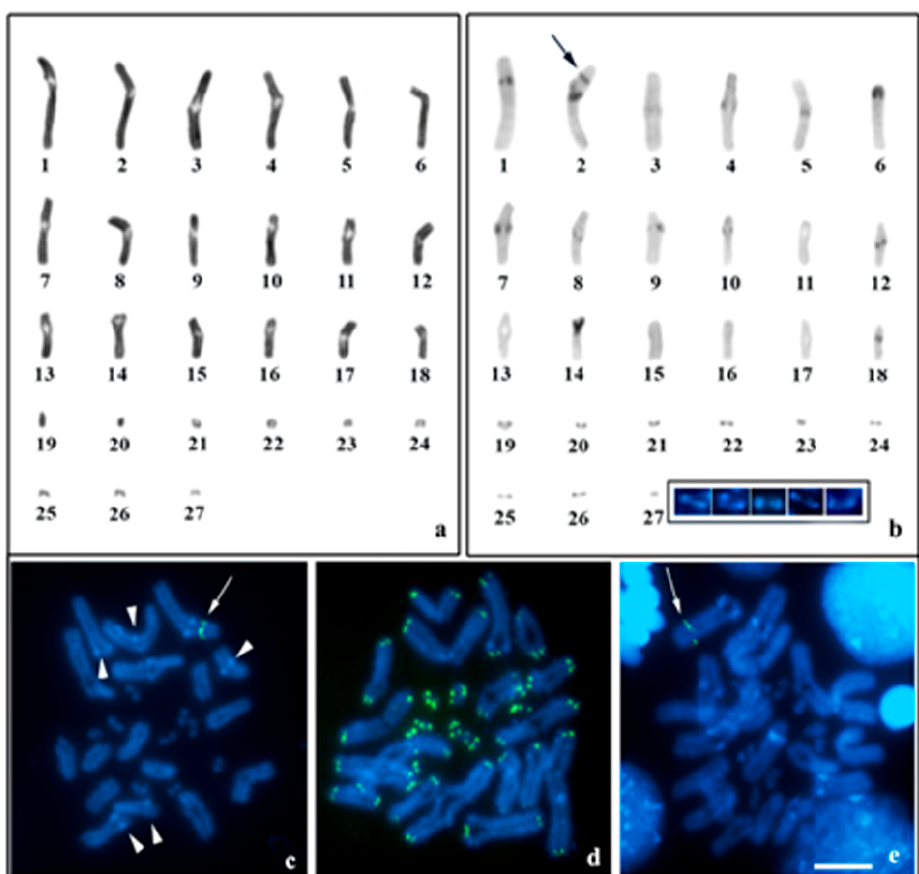
Figure 3. Karyotype of N. parvulus : ( a ) conventional staining with Giemsa, note the difference in size between microchromosomes and macrochromosomes; ( b ) C banding, the arrow on pair 2 indicates the additional C ‐ band on the short arm. In the insert, some specimens of microchromosomes subjected to DAPI staining after C ‐ banding; ( c ) 45S rDNA; DAPI+ heterochromatic blocks are indicated by arrowheads; ( d ) TTAGG repeats. ( e ) U2 snRNA. Bar = 10 μ m.